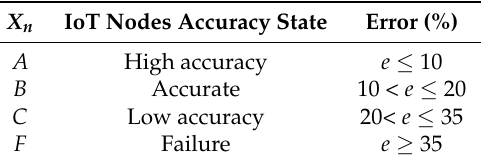
Table 1. Accuracy state of